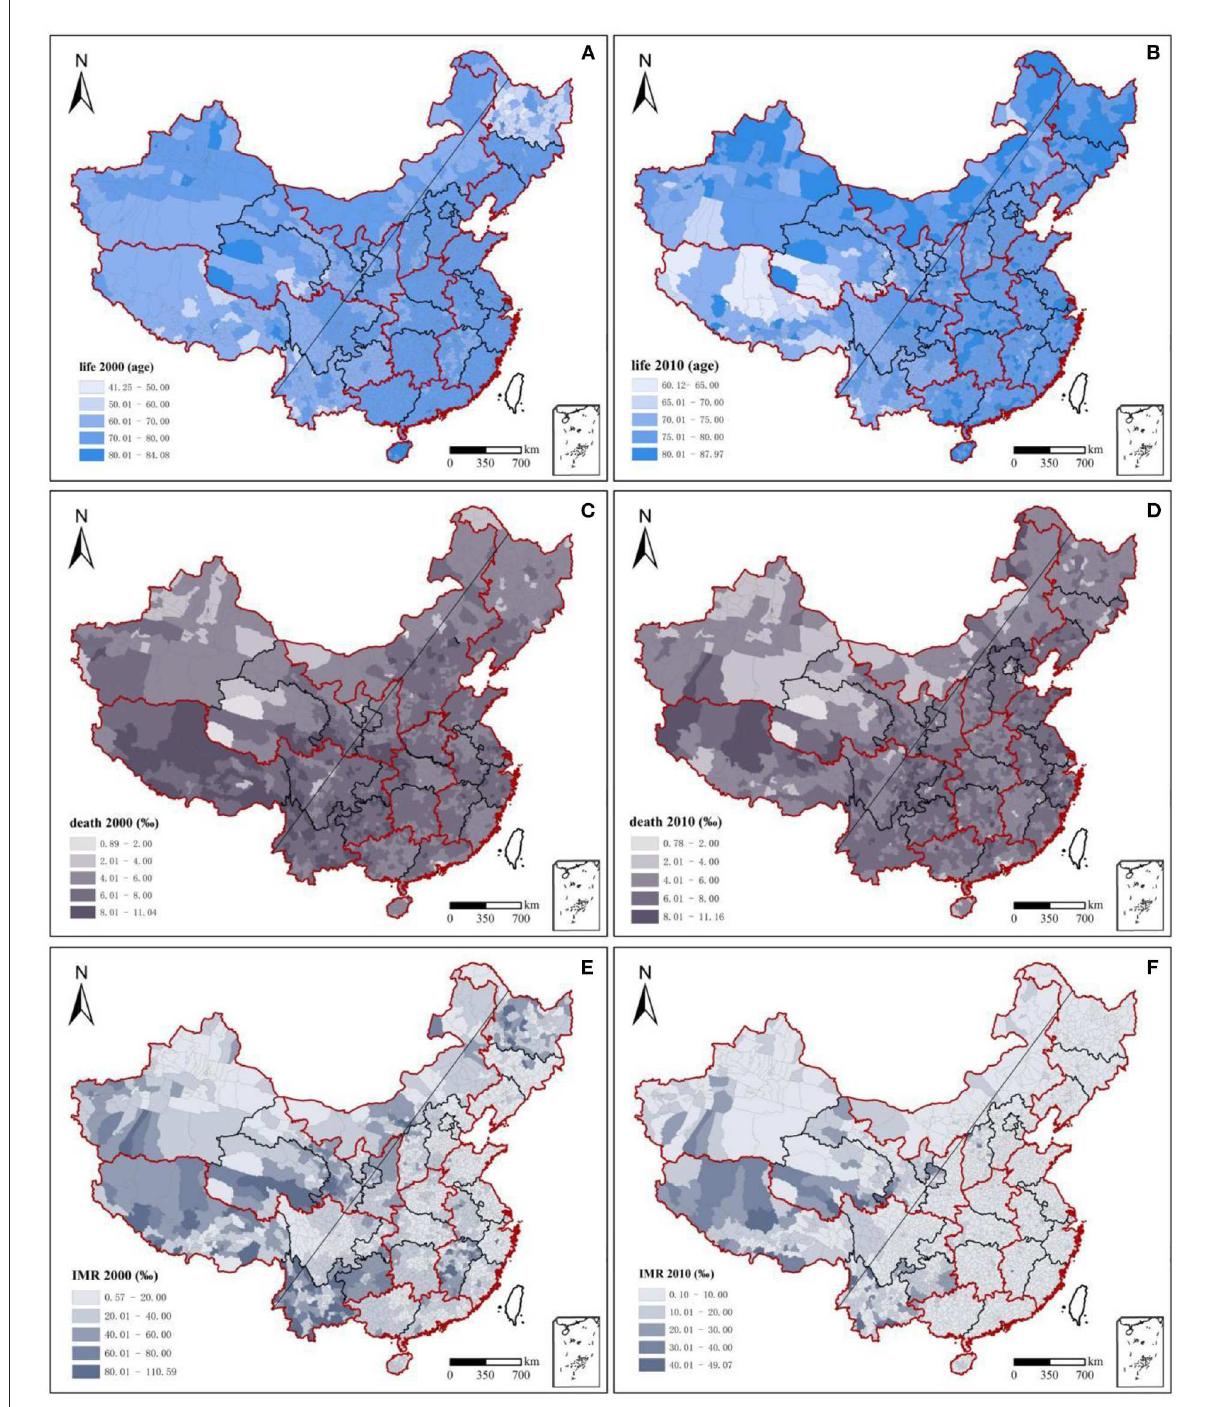
FIGURE1 Changes and spatiotemporal evolution of population health, 2000–2010. Red outline: seven geographical regions’ dividing lines; seven geographical regions: northeast China, east China, north China, central China, south China, southwest China, and northwest China. It was used to assist with east-west regional analysis; black outline: dividing lines of 31 provinces; slanting straight line: Hu Huanyong Line; Taiwan, Hong Kong, and Macao were not included in the